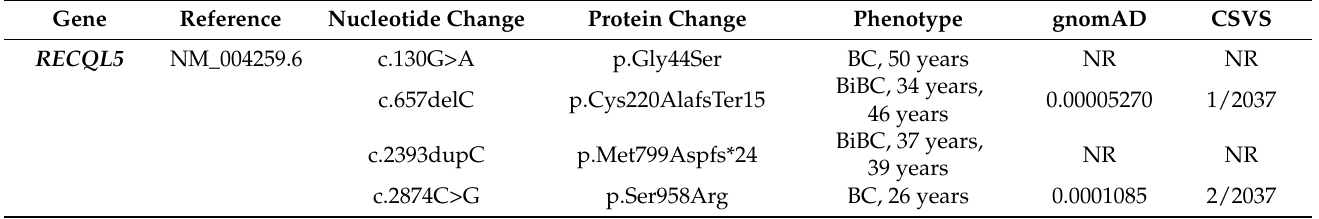
Figure 1. Map of the RECQL5 protein domains, with circles indicating the location of the (likely) pathogenic germline variants identified in our current and previous studies (Tables 2–4). Colored boxes indicate the protein domains, and gray boxes the 19 coding exons of the RECQL5 gene. The figure was created with RStudio (RStudio Team (2020). RStudio: Integrated Development for R. RStudio, PBC, Boston, MA, USA, URL http://www.rstudio.com/) (Accessed on 25 February 2022). Figure adapted from Newman et al. [40]. Table 4. RECQL5 LoF protein-truncating variants found in 700 samples in Tavera-Tapia and added to the current